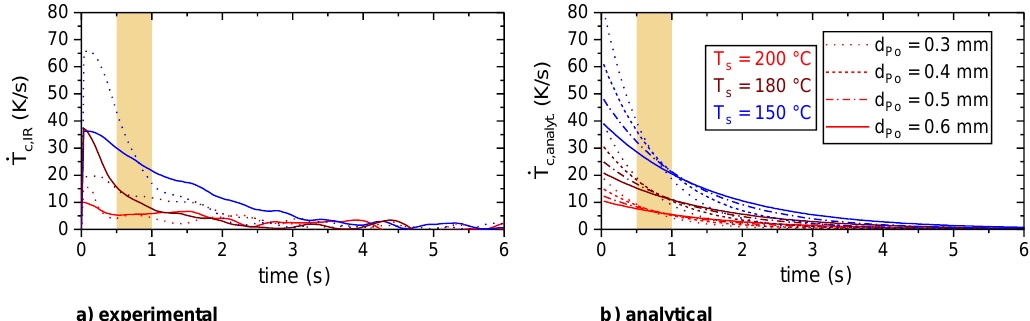
Figure 15. Cooling rates of the experimental ( a ) and analytical ( b ) temperature profiles for different layer heights, d Po , and substrate temperatures, T s . For the analytical approximation, T IR,e and T IR,plat were interpolated linearly between the average values for the layer heights 0.3 and 0.6 mm (cf. Table 2). . T Hence, T IR, plat was estimated based on c , avg ( 0.5 − 1 s ) , which strongly depended on T IR,plat and was . T nearly independent of d Po (cf. Figure 16) c , avg ( 0.5 − 1 s ) is the average cooling rate within 0.5 and 1 s after extrusion.